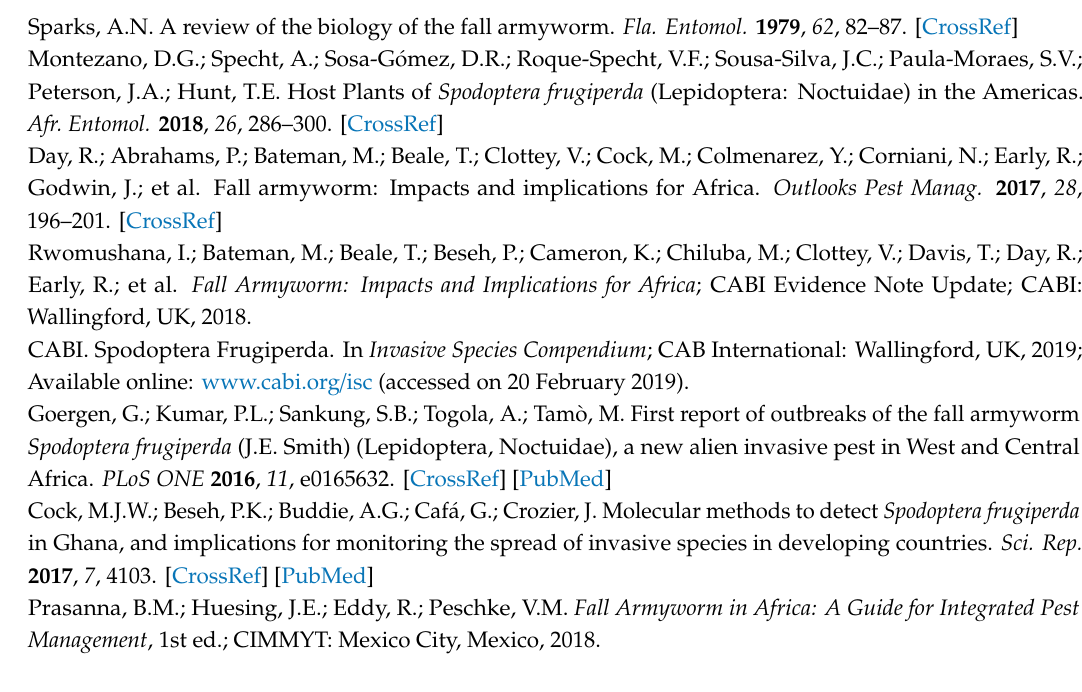
Table S1: Description of the study sites in Ghana (GH) and Benin